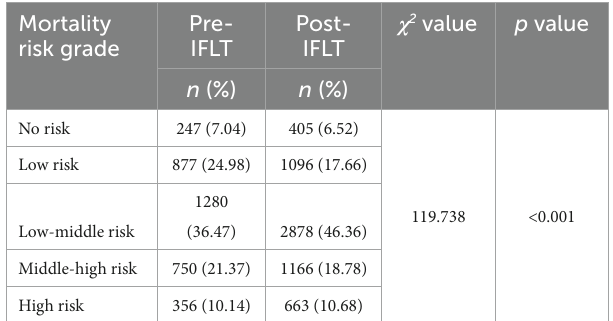
TABLE 5 Distribution of patients with different risk grades of death admitted to the organ transplant department in the pre- and post-IFLT periods.